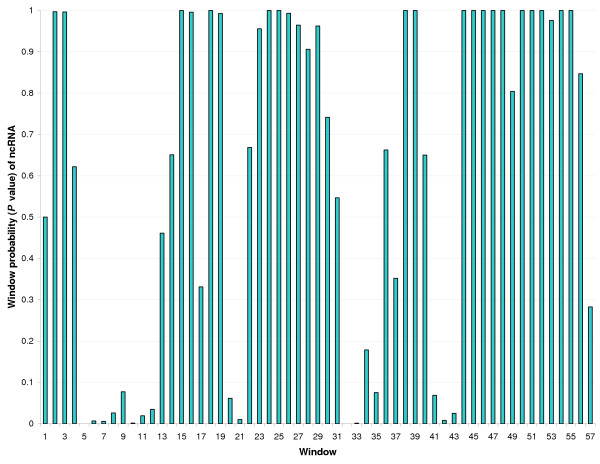
ncRNA probabilities (P values) of scanning windows iterating through a 23S rRNA. Probabilities of ncRNA computed by the Dynalign/LIBSVM classifier for 57 150-nucleotide-long scanning windows iterating through a global alignment of Bacillus subtilis and Bos taurus 23S rRNA in steps of 75.